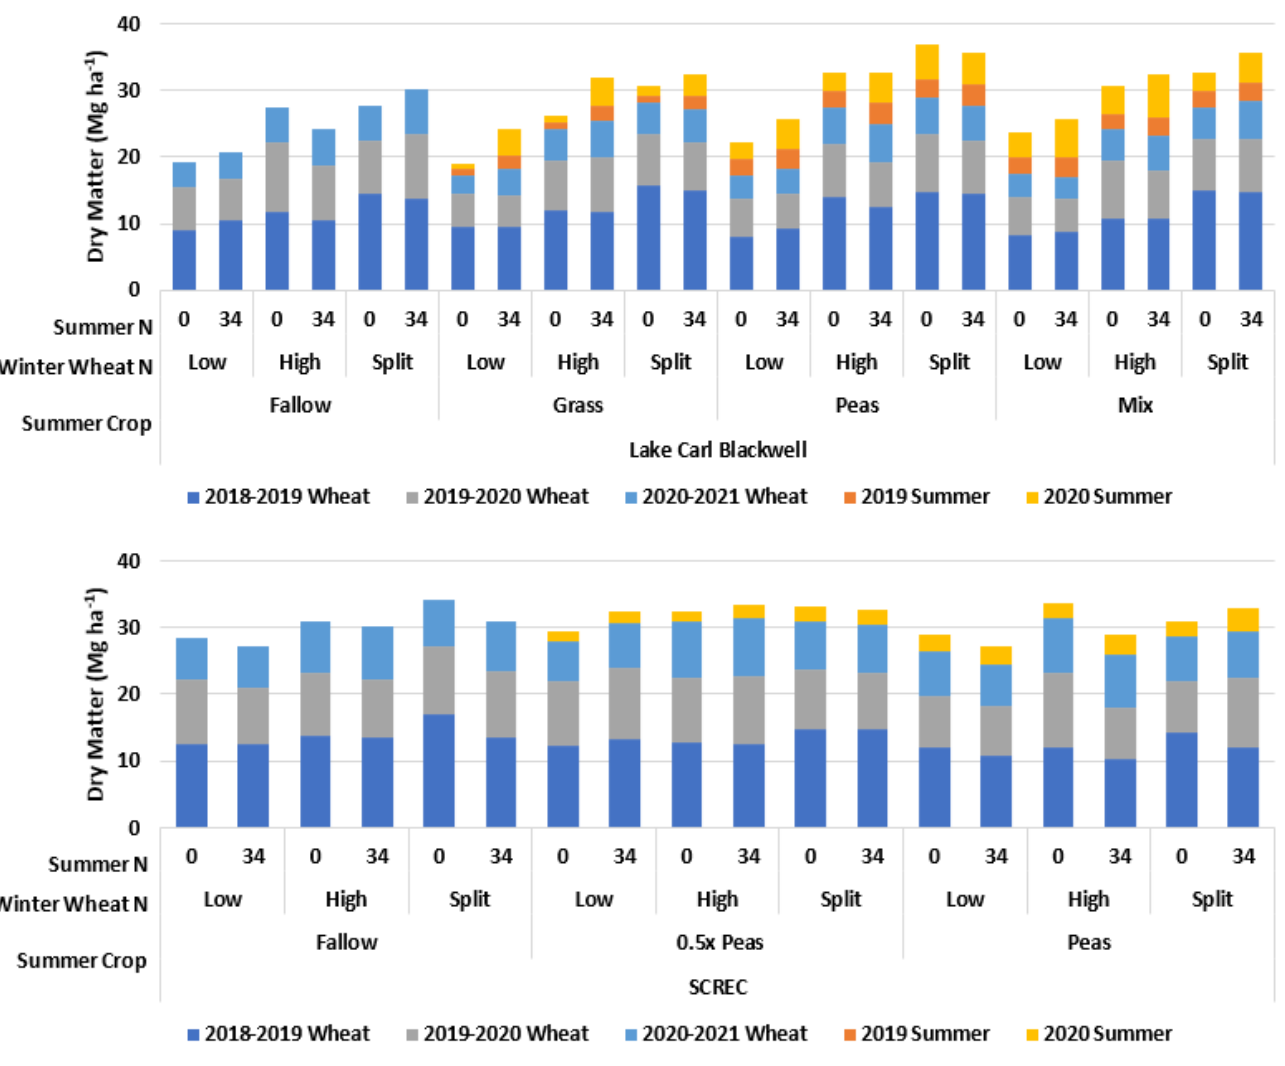
Figure 1. Average dry matter biomass production (Mg ha − 1 ) from each season of production for LCB (Top) and SCREC (Bottom). Means are presented for each of the summer N application rates (kg N ha − 1 ) within each of the summer crop species: fallow, cowpeas (Peas), crabgrass (Grass), cowpea-crabgrass mixture (Mix), and half-planted rate of Cowpeas (0.5 × Peas), within each of the winter (67 kg N ha − 1 pre-plant and 67 kg N ha − 1 top-dress. Table 3. ANOVA table with degrees of freedom (DF), sums of squares, mean squares, F -value, and p -value for each of the sources of variances for winter wheat dry matter production at two locations in Oklahoma.